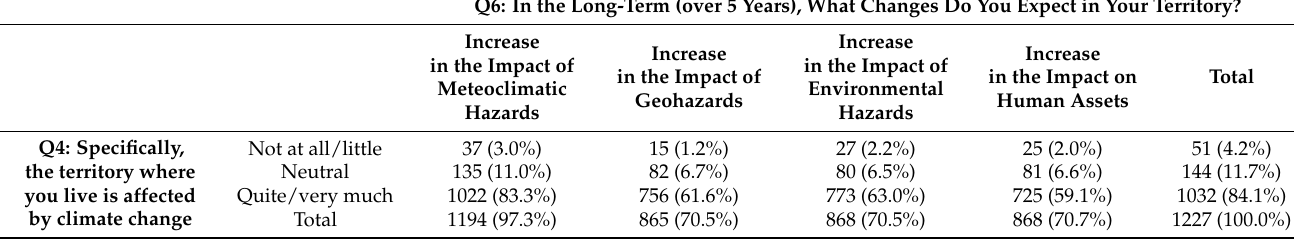
Table 8. Cross table of Q4 and Q6 with frequencies (percentages) of the